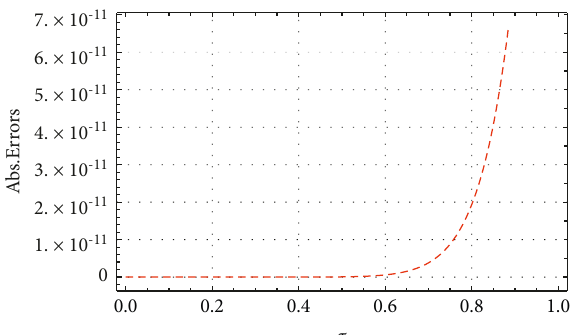
Figure 15: The absolute error for the real part of Example 4.